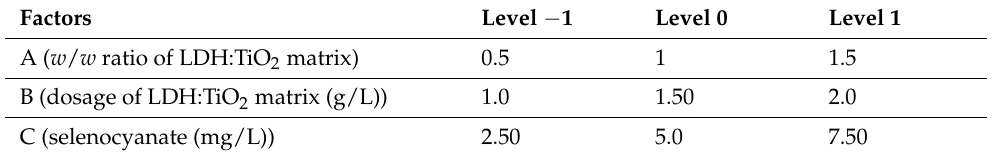
Table 1. Levels and factors for photocatalysis experiments using RSM modeling. Factors